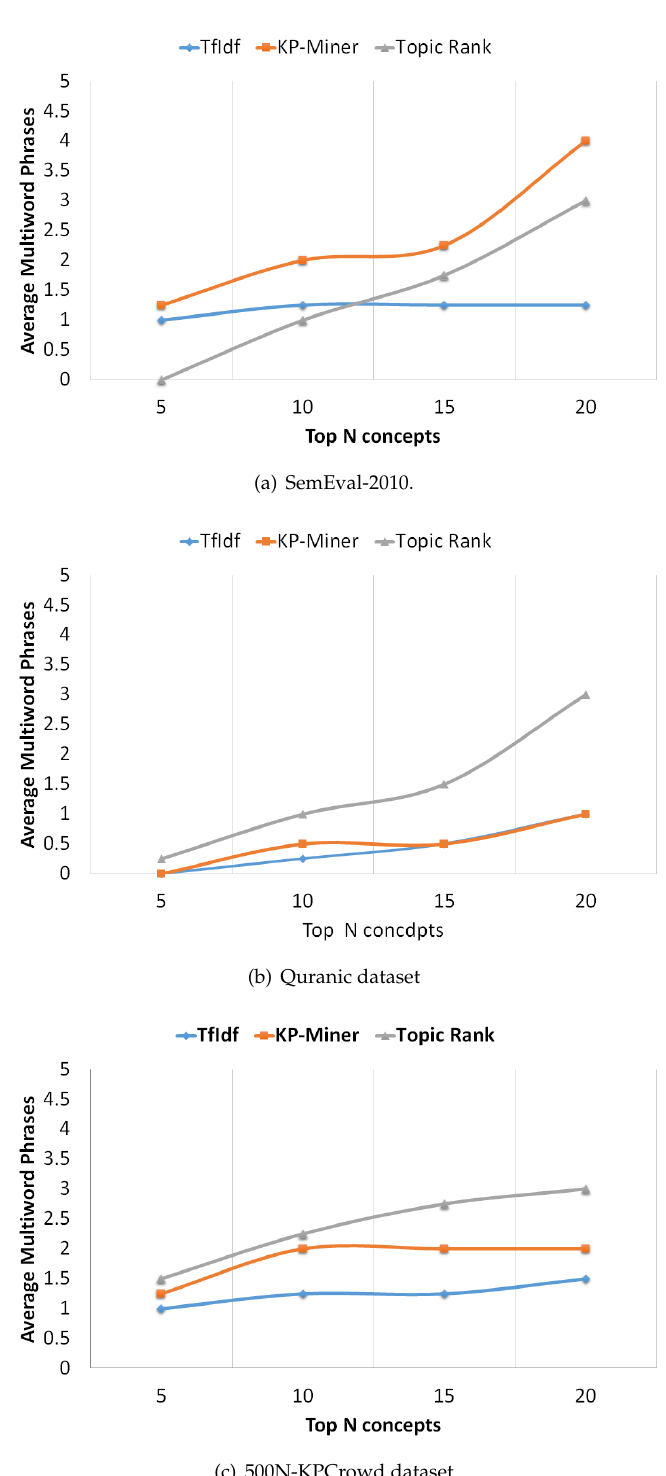
Figure 3. Average Multiword Phrases curves for selected